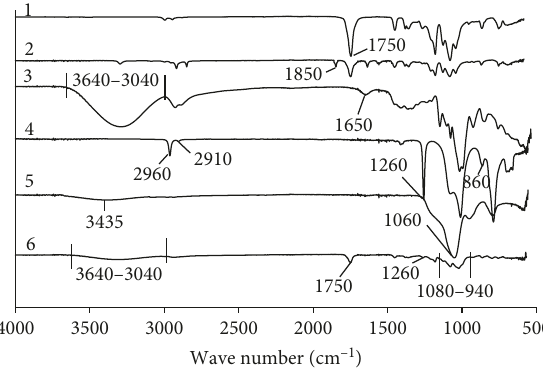
Figure 4: FTIR spectra of PLA (1), MPLA (2), TPS (3), P (4), A-SiO 2 (5), and PLA/MPLA/TPS/P/A-SiO 2